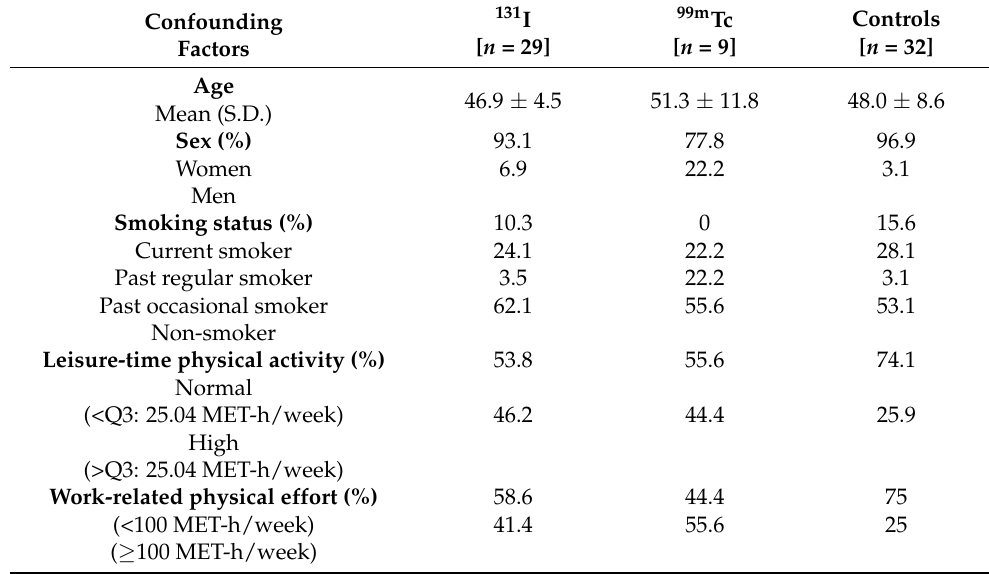
Table 2. Characteristics of the examined groups with respect to mean age, sex, smoking status, leisure time physical activity, and work-related physical effort. The control group was used as a match for possible confounding factors that may affect cell